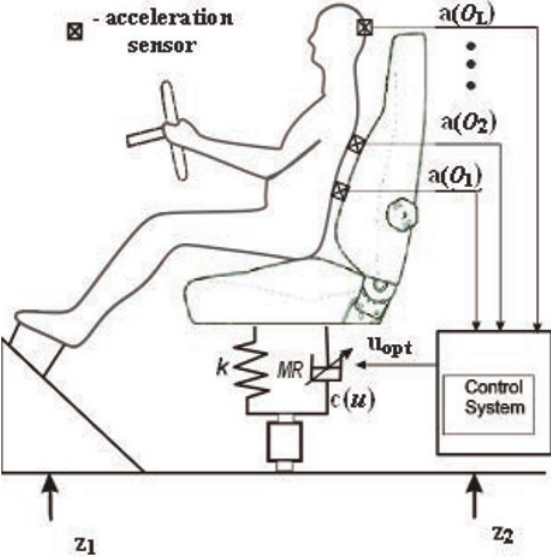
Fig. 1. The concept of MR suspension control Figure 1. The concept of MR suspension control including biome- chanics of driver. Conventional control strategies can have low effectiveness in this case. An unknown function can be described as follows: where U represents the control voltage of MR damper, structures, and b represent the vector of biomechanical parameters of a driver. The power spectral density vector